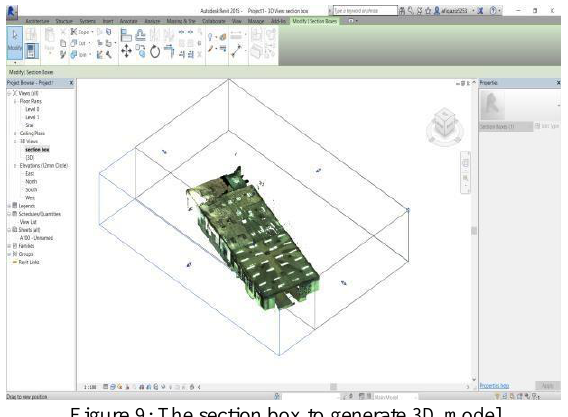
Figure 9: The section box to generate 3D model.